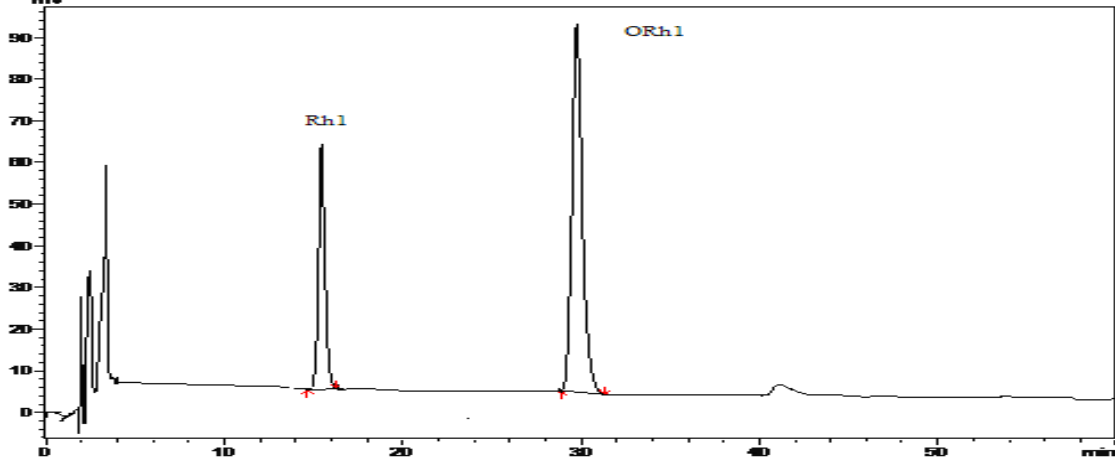
Figure 2. HPLC spectra of Rh (compound 3 ) and the reaction product of ORh 1 1 (compound 4 ) HPLC conditions: isocratic elution with 100% MeOH for 60 min.